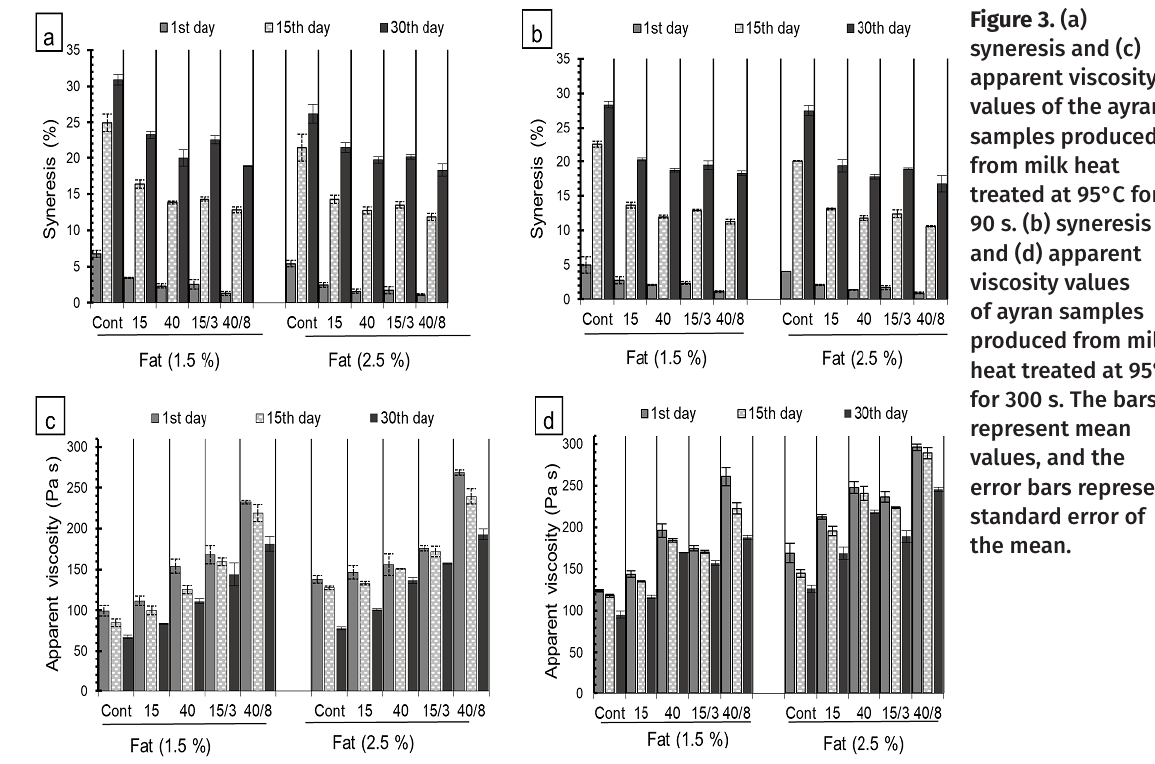
syneresis and (c) apparent viscosity values of the ayran samples produced from milk heat treated at 95°C for 90 s. (b) syneresis and (d) apparent viscosity values of ayran samples produced from milk heat treated at 95°C for 300 s. The bars represent mean values, and the error bars represent standard error of the